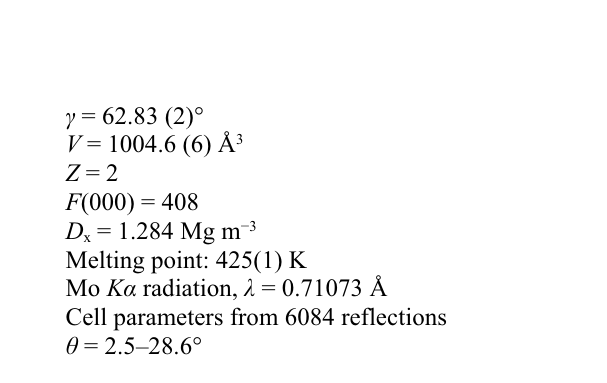
View of the crystal structure of (I), showing the O—H···O and C—H···O interactions along [100] direction. [Symmetry codes: (iv) x , 1 + y , z (v) 1 + x , 1 + y , z